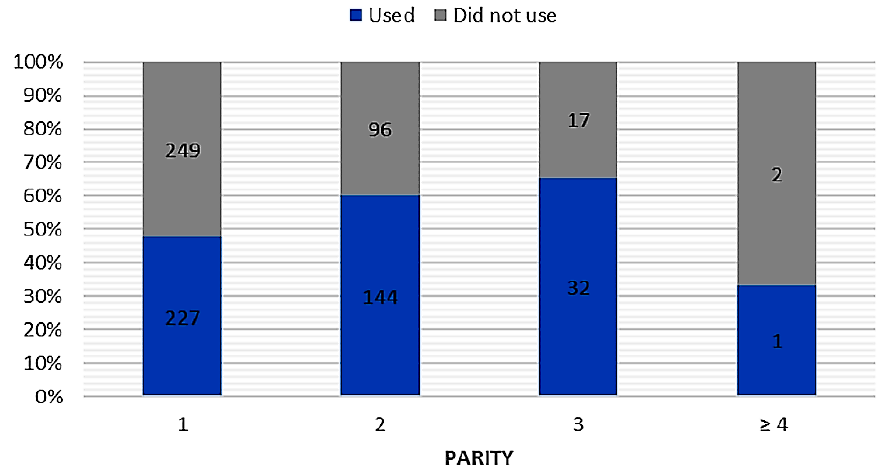
Figure 4. The parity and attempts to use breast milk in prevention and treatment of mucosal ailments (“used” vs. “did not use”).